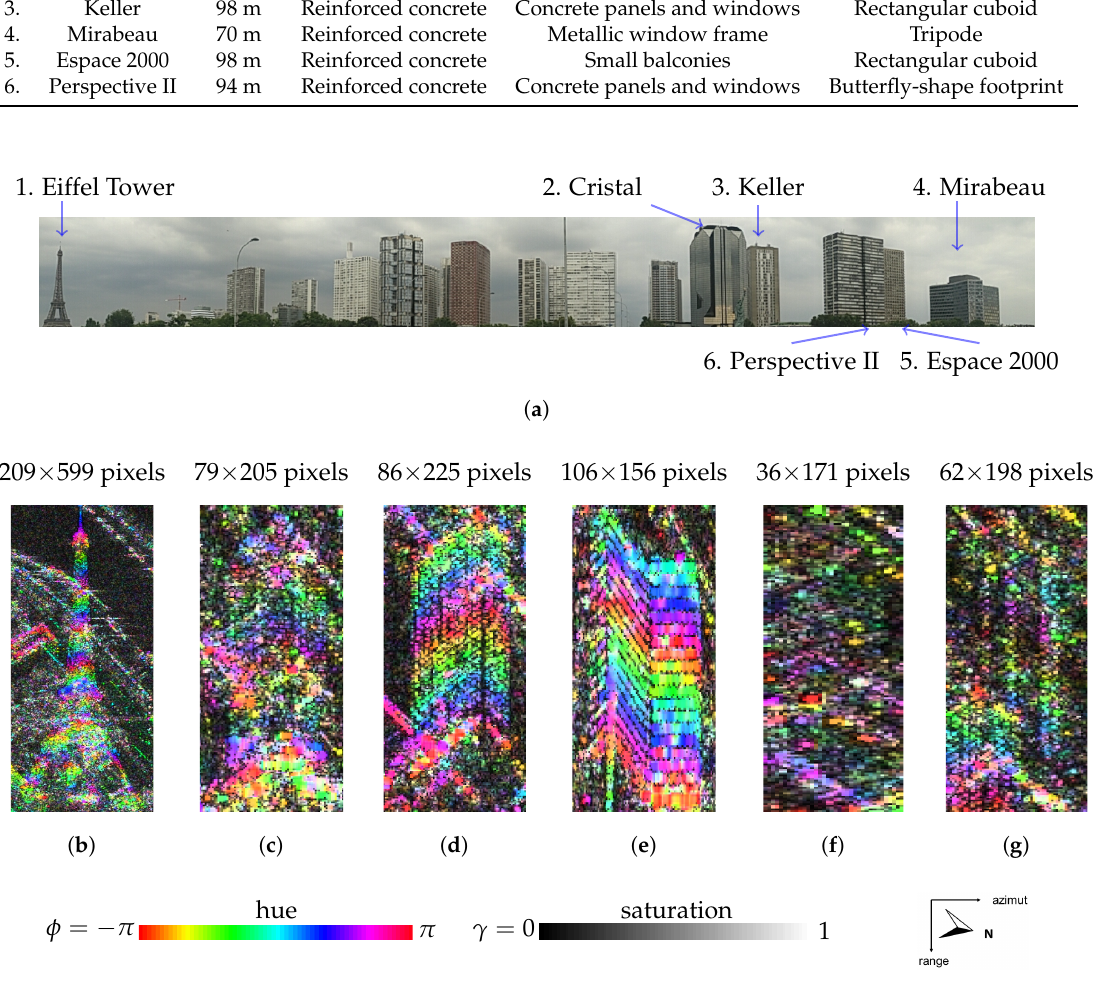
Figure 3. Optical image and interferometric fringes between the reference image and the 22-04-2009 image for the Eiffel, Cristal, Keller and Mirabeau Towers. ( a ) Front de Seine c (cid:13) Sylvain Lobry ( b ) Eiffel Tower fringes; ( c ) Cristal Tower fringes; ( d ) Keller Tower fringes; ( e ) Mirabeau Tower fringes; ( f ) Espace 2000 Tower; ( g ) Perspective II Tower. The phase φ is coded by the hue while the degree of coherence γ is coded by the saturation. The value is the intensity of the reference